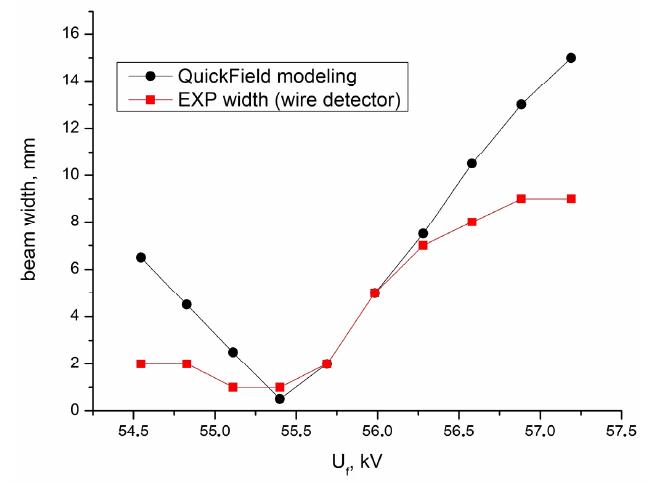
Figure 4. Comparison of the primary ion beam with measured by wire array detector (red squares) and modeled by QuickField Student Edition Freeware [23] code (black circles) for different focus- ing